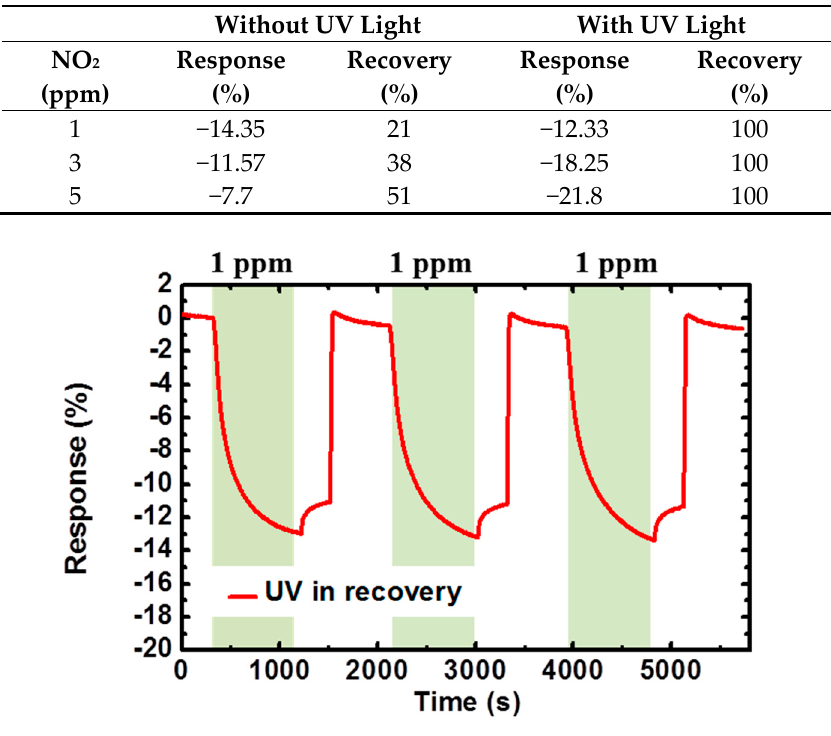
Table 1. Gas sensing properties of UV light and without.